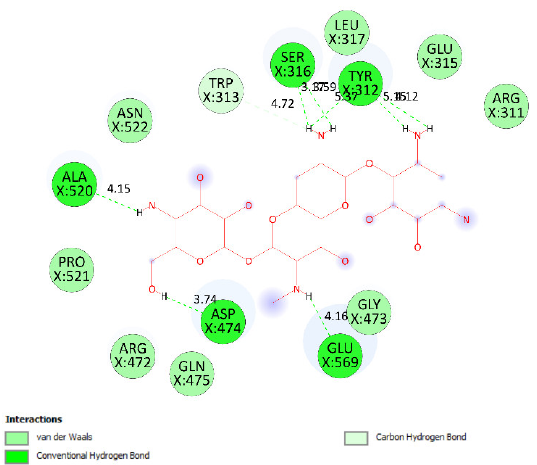
Figure 23. The significant ligand interactions indicated in one 2D diagram between pose 172, the standard drug apramycin, and enzyme 2VF5.